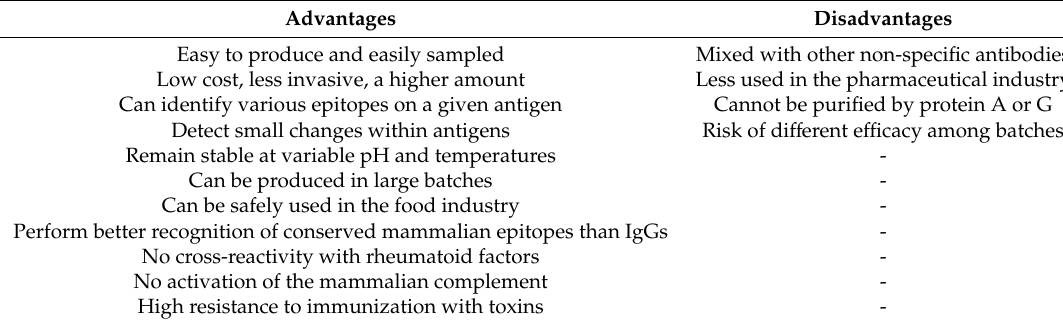
Table 2. Advantages and disadvantages of IgY polyclonal